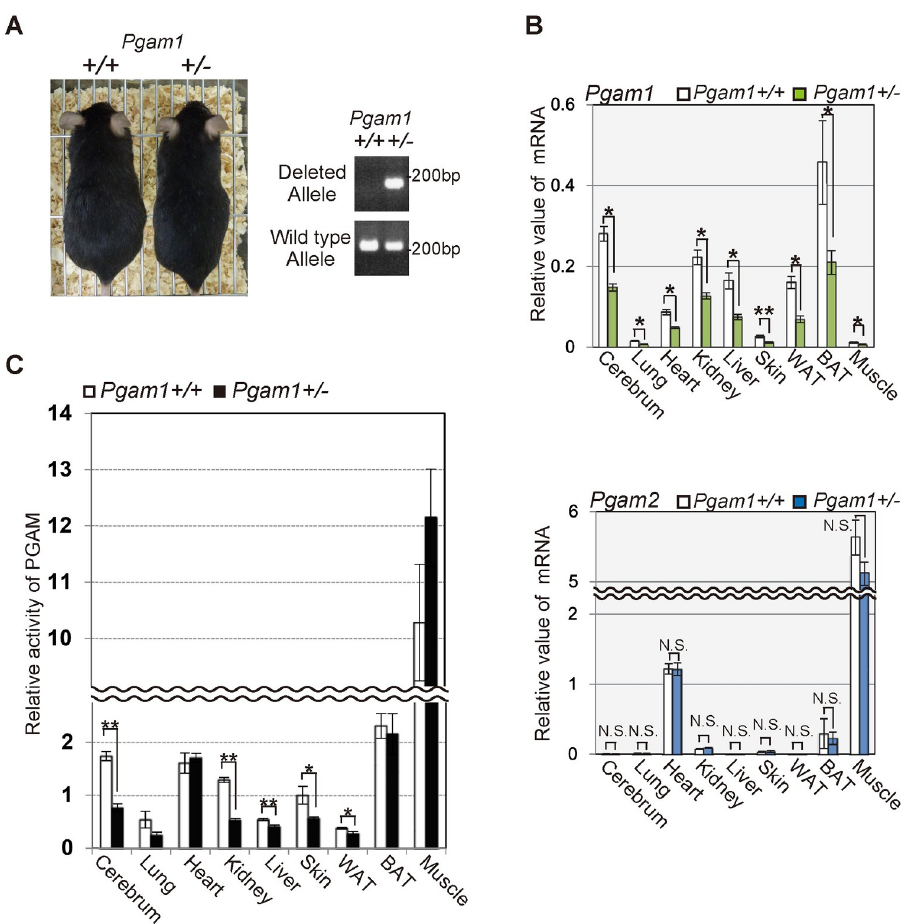
Fig 2. Heterozygous Pgam1 knockout mice were viable. (A) Pgam1 +/− mice are viable. Representative images of wild-type and Pgam1 +/− mice at 35 weeks (left panel). Genomic PCR in indicated mice was performed to verify the wild-type or deleted alleles for Pgam1 (right panels). (B and C) Assessment of PGAM expression levels and enzymatic activity in various tissues from wild-type (n = 5) and Pgam1 +/− mice (n = 5) at 35 weeks. (B) Pgam1 +/− mice displayed approximately 50% reduction for Pgam1 mRNA levels, compared to those from wild-type mice (upper panel), while Pgam2 mRNA levels did not show significant difference (lower panel). (C) The PGAM activity were measured in indicated tissues. Each data is shown as relative values against those in control. +/+; wild-type, +/-; heterozygous